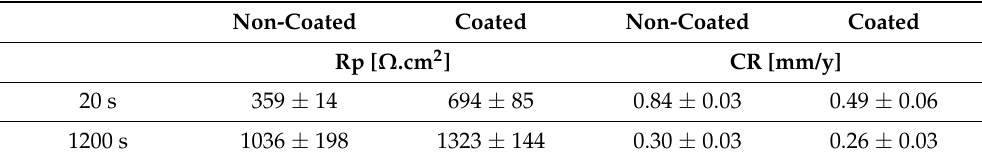
Table 3. Average polarization resistance and corrosion rates obtained for the machined and coated samples tested. Non-Coated Coated Non-Coated Coated